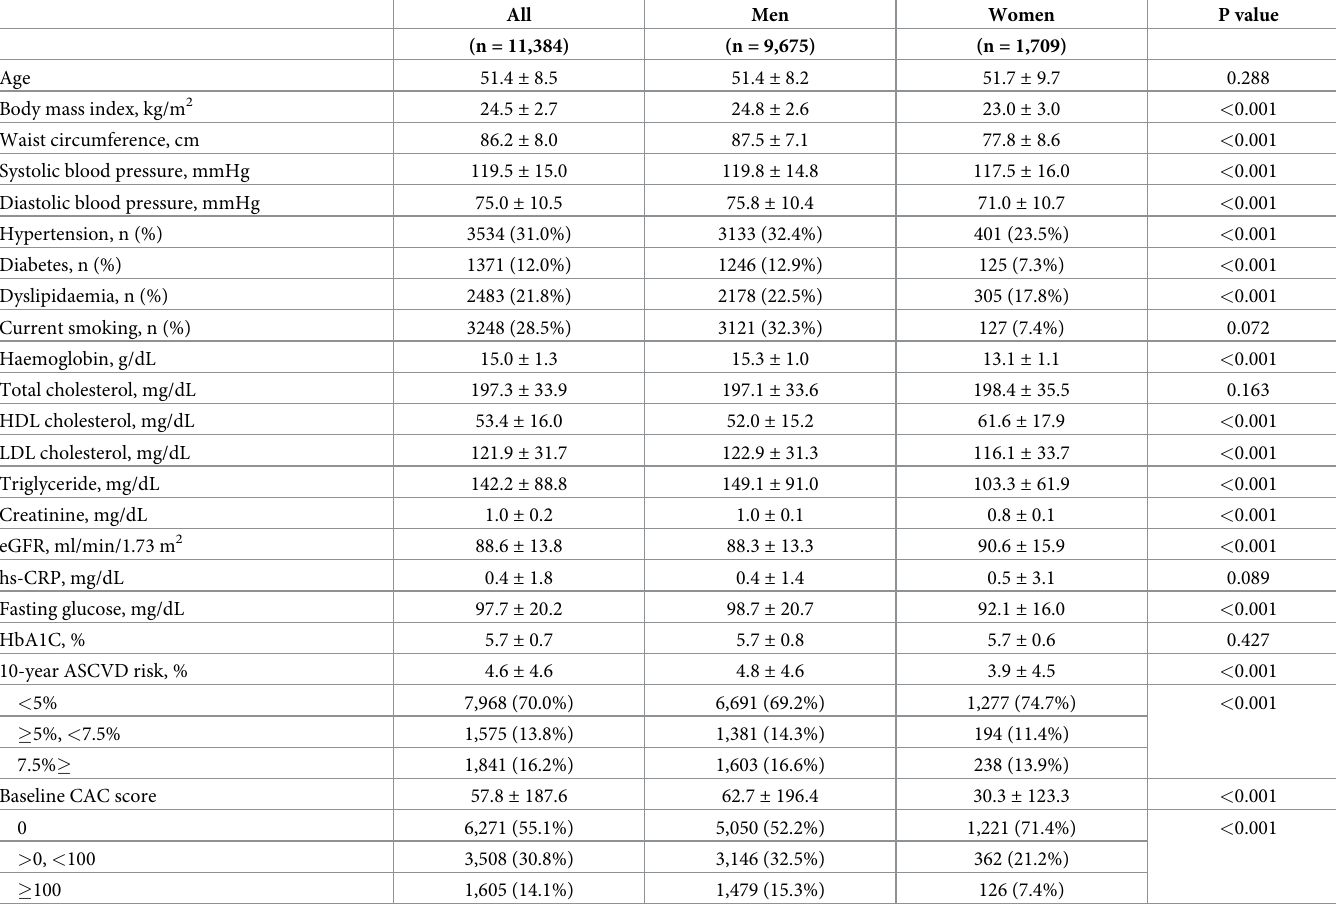
Table 1. Baseline